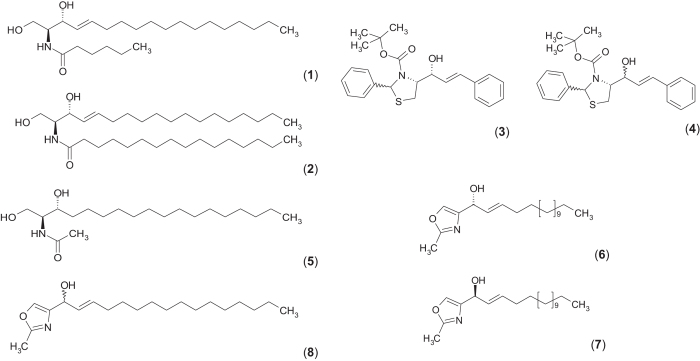
Natural ceramide and synthetic ceramide analogs. Chemical structures of C6-ceramide (1), C16-ceramide (2), C2-dihydroceramide (5) and synthetic ceramide analogs HPL-39N 4-[(1R)-(E)-1-Hydroxy-3-phenyl-allyl]-(2RS,4R)-2-phenyl-thiazolidin-3-carbonic acid-t-butylester (3), HPL-38N 4-[(1RS)-(E)-1-Hydroxy-3-phenyl-allyl]-(2RS,4R)-2-phenyl-thiazolidin-3-carbonic acid-t-butyl-ester (4), HPL-1R36N (1R)-(E)-(2-Methyl-oxazol-4-yl)-hexadec-2-en-1-ol (6) and HPL-1S36N (1S)-(E)-(2-Methyl-oxazol-4-yl)-hexadec-2-en-1-ol (7), HPL-1RS36N (1RS)-(E)-(2-Methyl-oxazol-4-yl)-hexadec-2-en-1-ol (8).